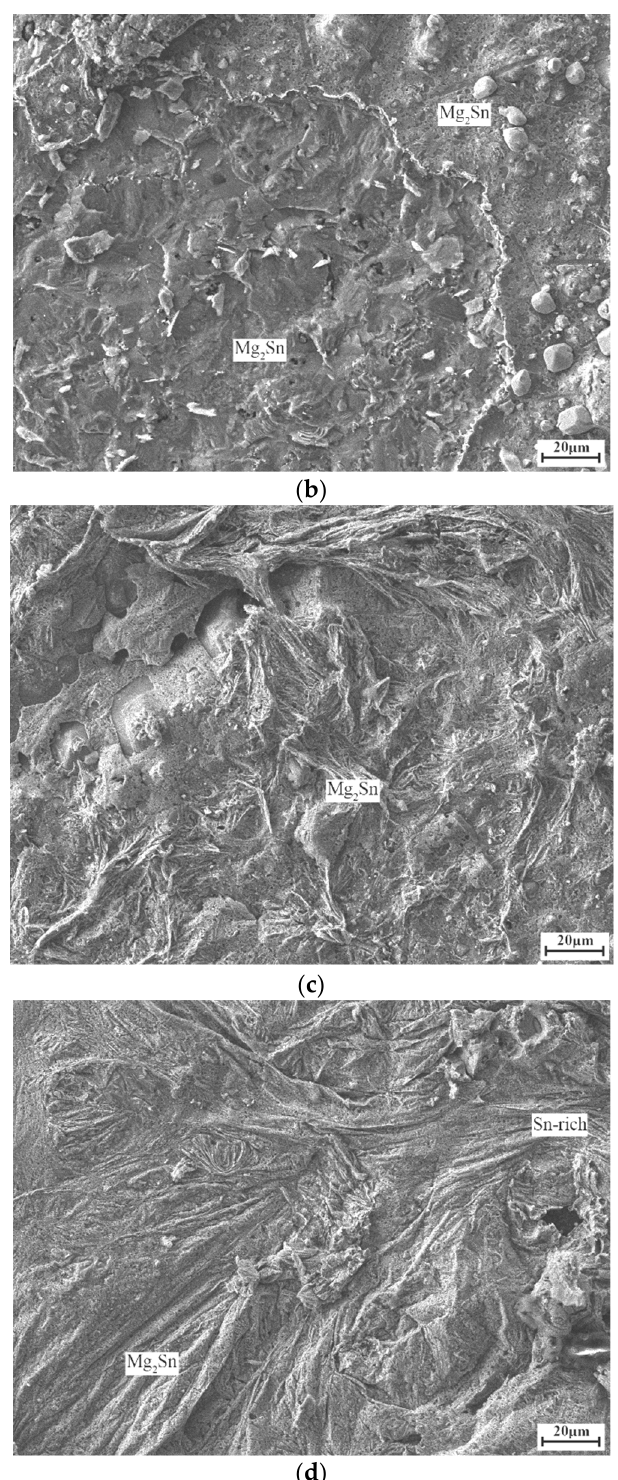
Figure 14. Fractographs of the AZ31 magnesium alloy/6061 aluminum alloy joints bonded with the Sn-10Zn-0.1RE filler metal after aging at 150 °C ( a ) the 6061 aluminum alloy side after 50 h of aging; ( b ) the AZ31 magnesium alloy side after 50 h of aging; ( c ) the 6061 aluminum alloy side after 100 h of aging; ( d ) the AZ31 magnesium alloy side after 100 h of aging.